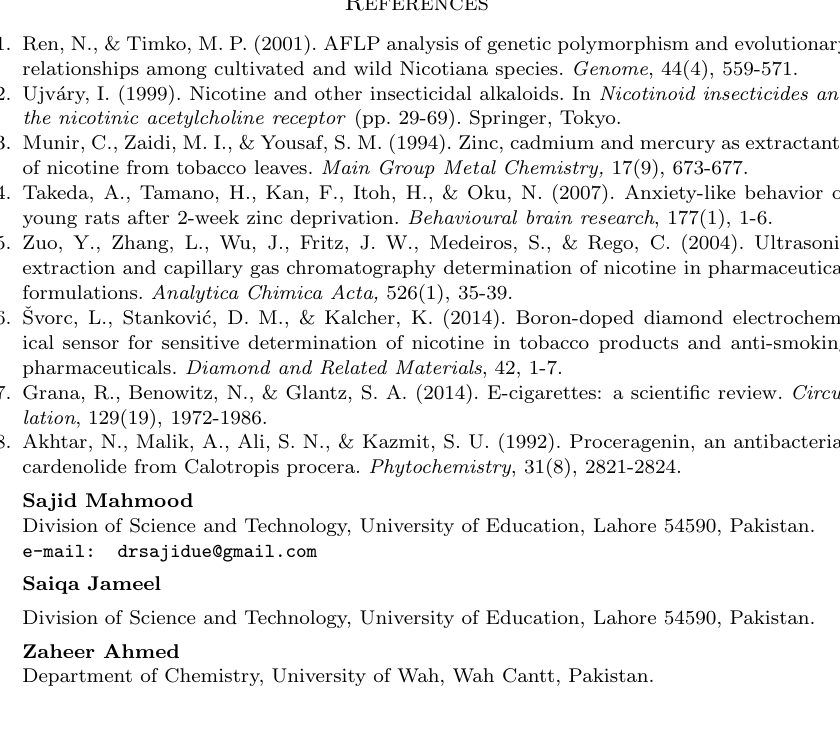
Gram positive organisms